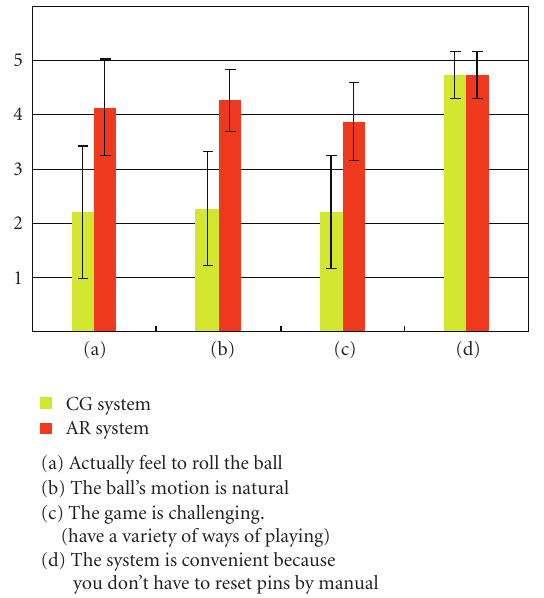
Figure 24: Answer of questionnaire about the reality of playing